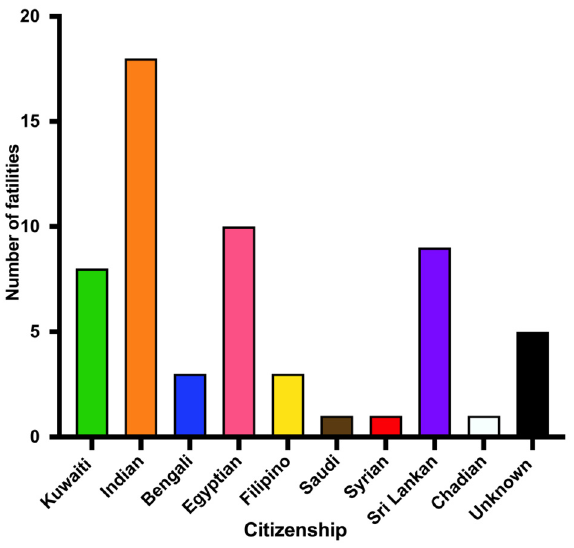
Figure 6. CO poisoning confirmed cases (n = 59) by country of citizenship (2014–2018).